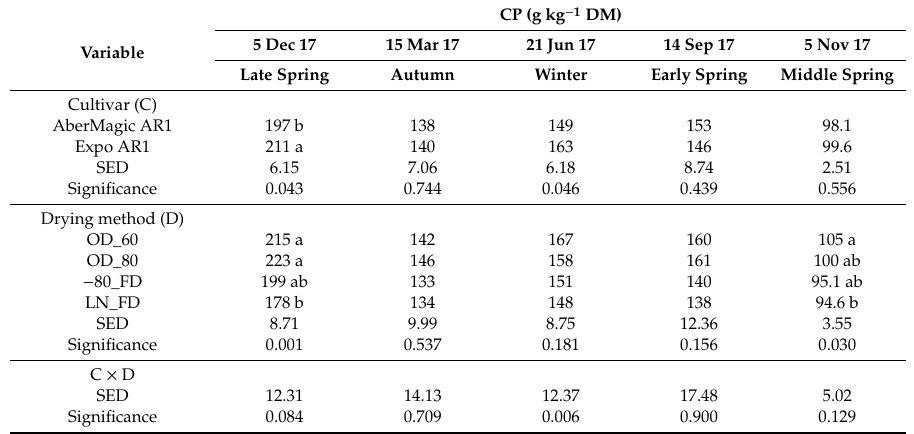
Table 2. Crude protein concentration (CP, g kg − 1 DM) in AberMagic AR1 and Expo AR1 dried under di ff erent procedures in five harvest.